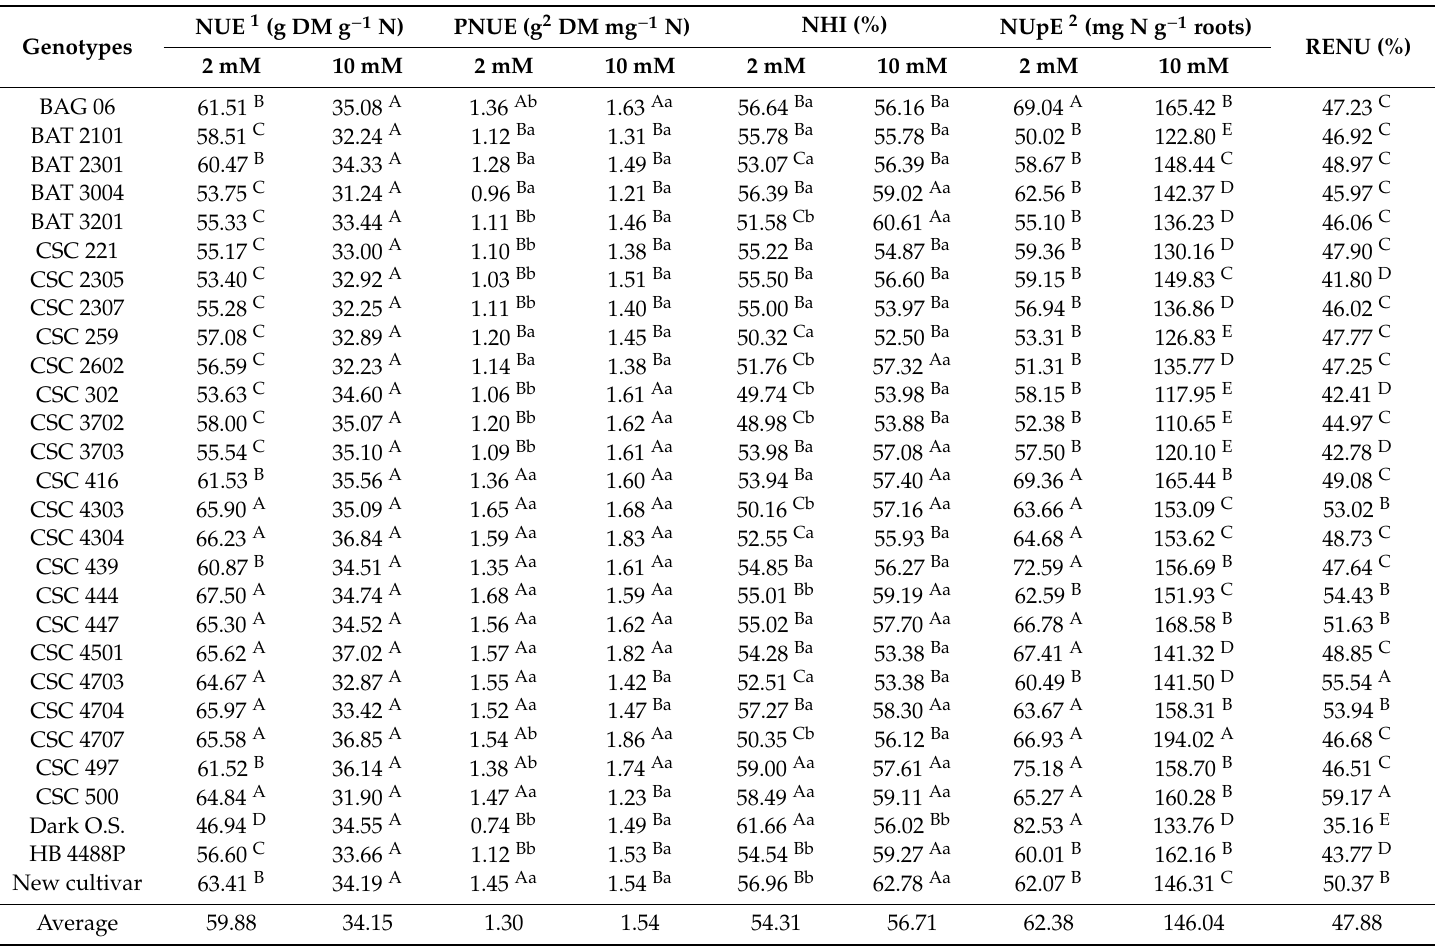
Table 4. N utilization e ffi ciency (NUE; g DM g − 1 N), physiological N use e ffi ciency (PNUE; g 2 DM mg − 1 N), N harvest index (NHI; %), N uptake e ffi ciency